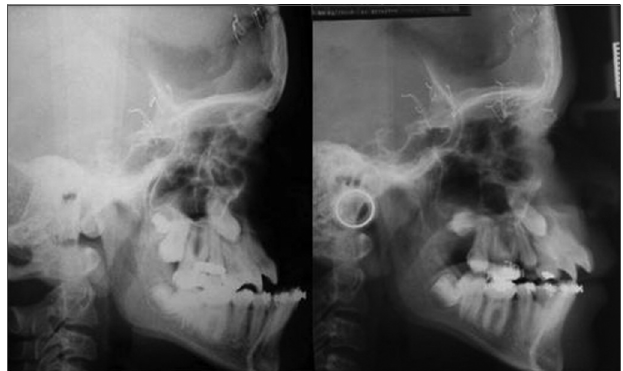
Figure 1. Lateral teleradiograph of a patient undergoing a Le Fort III type osteotomy followed by midface distraction osteogenesis with a rigid external device (RED). Left: preoperative. Right: early postoperative.